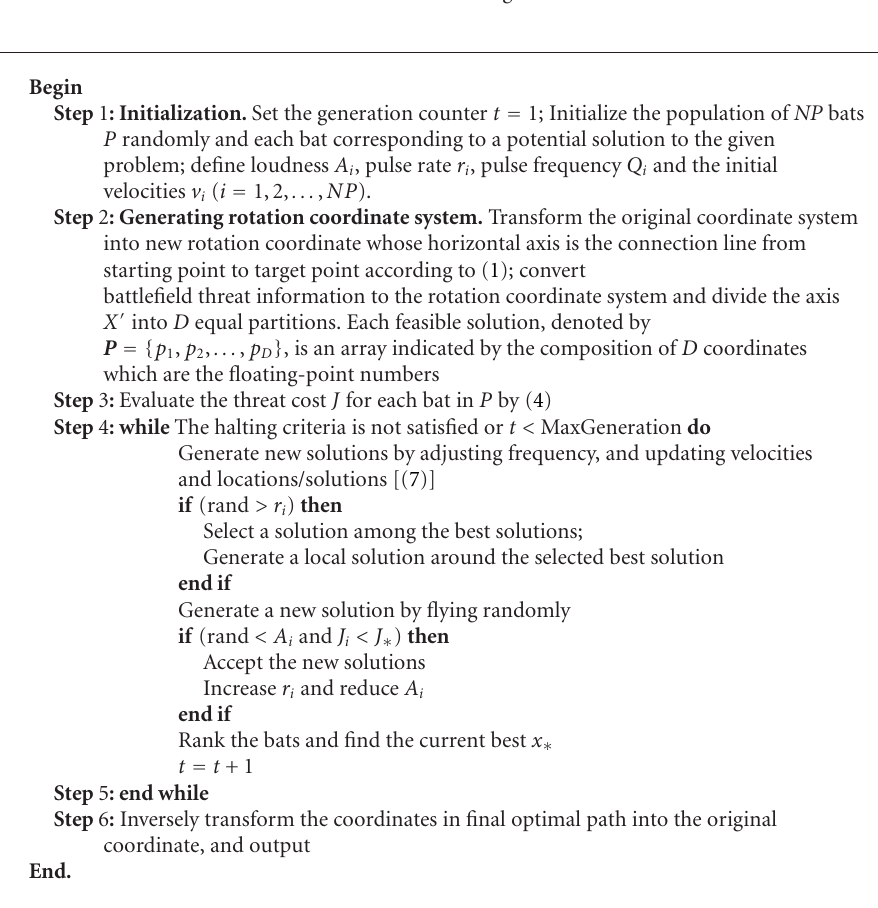
Algorithm 2: Algorithm of BA for UCAV path